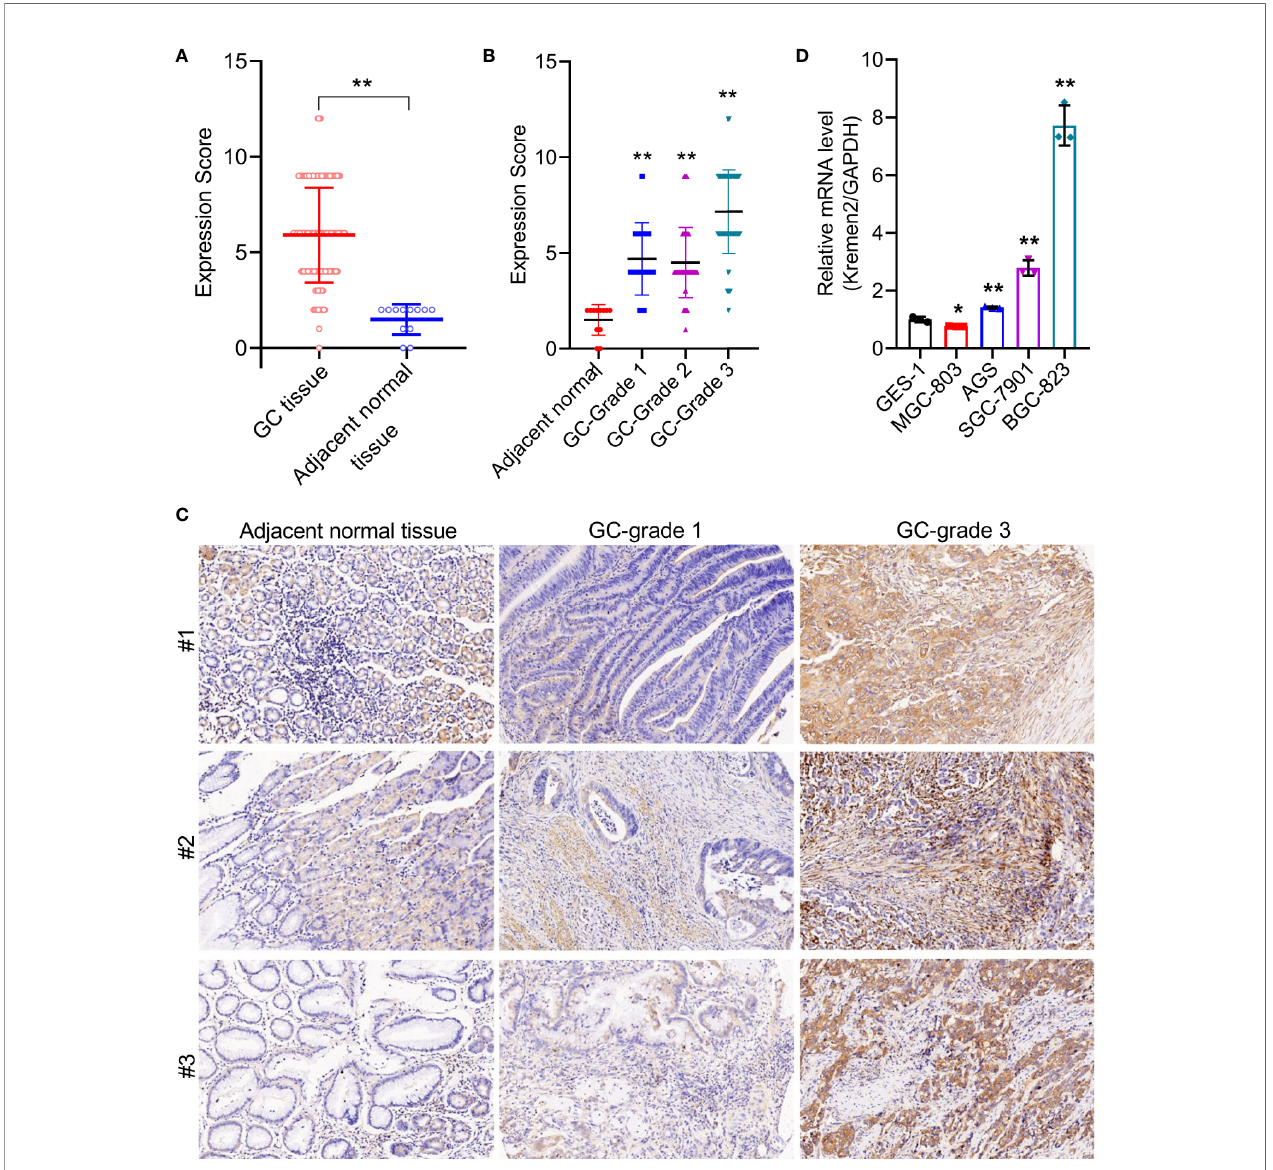
FIGURE 1 | Kremen2 was highly expressed in GC tissues and cultured cell lines, and was positively correlated with pathological grade. (A) The protein levels of Kremen2 in gastric cancer tissues and adjacent normal tissues. (B) The protein levels of Kremen2 adjacent normal and cancer with different pathological grade. Kremen2 expression of 196 gastric cancer tissues, eight adjacent normal stomach tissue and four stomach tissues were detected using IHC, and expression score was calculated according to immunostaining intensity and positive expression rate. (C) Kremen2 expression was positively correlated with pathological grade. (D) Kremen2 expression was up-regulated AGS, SGC-7901, BGC-823, while down-regulated in MGC-803 gastric cancer cell line, compared with normal gastric mucosa epithelial cell line GES-1. The mRNA levels of Kremen2 were measured by qRT-PCR. * P < 0.05; ** P < 0.01; *** P < 0.001.